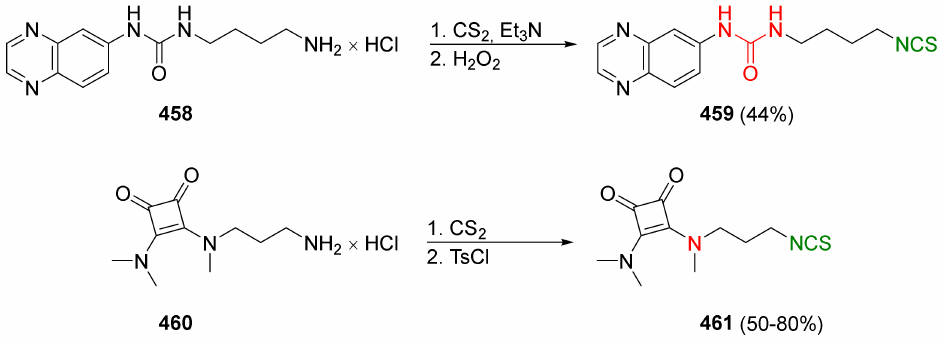
Figure 51. Synthesis of SFN analogues 459 and 461